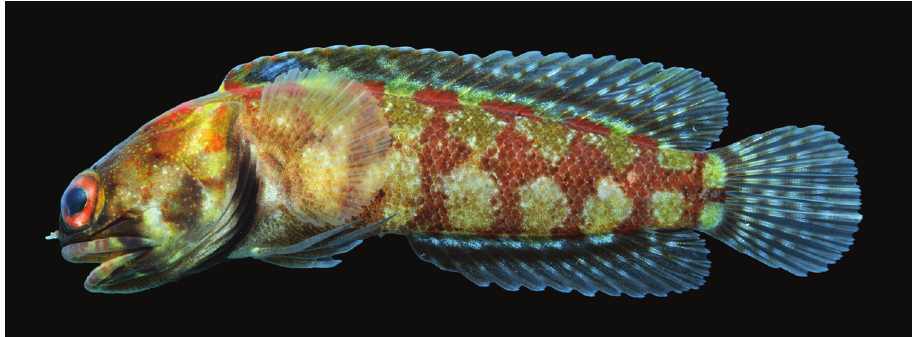
Figure 8. Opistognathus vicinus , CIUFES 0796, holotype, 43.0 mm SL, male, Ilha Rasa de Dentro, Guarapari, Espírito Santo, Brazil. Photograph by Raphael M. Macieira.